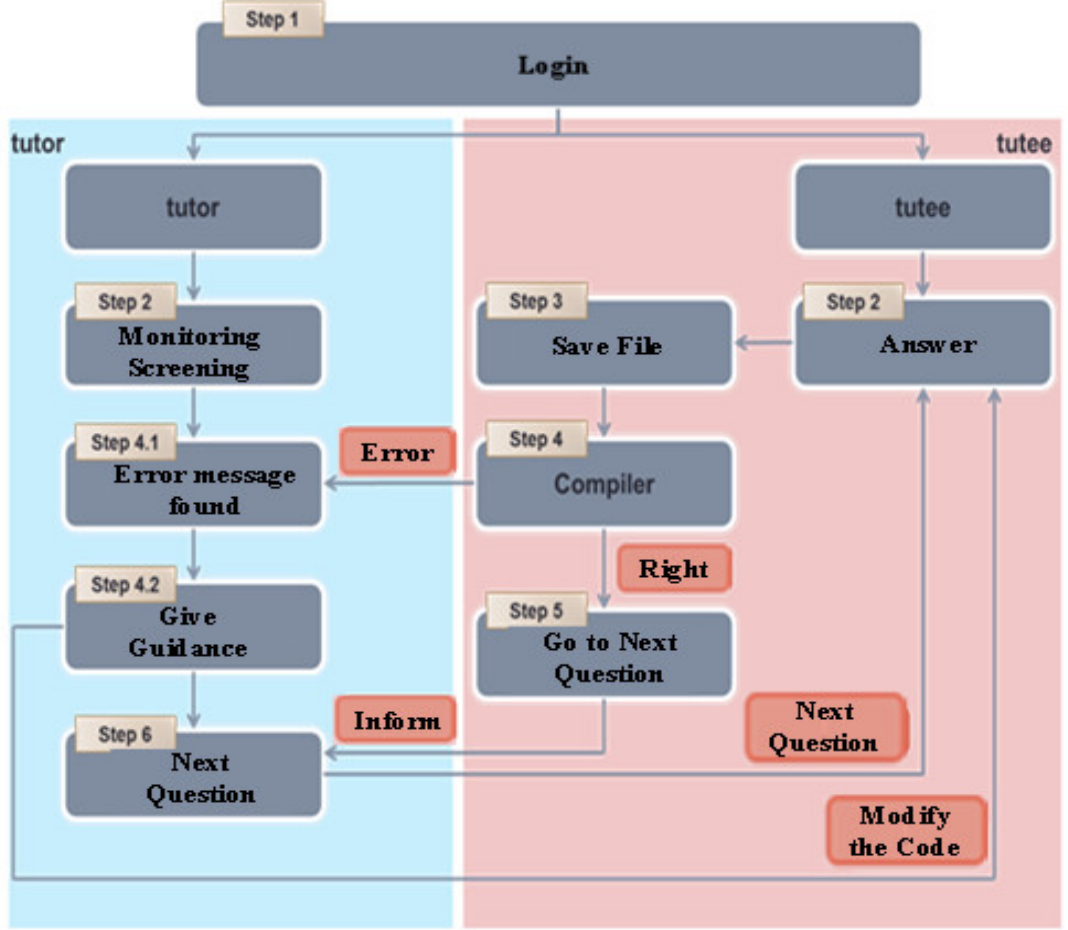
Figure 1. System procedure.